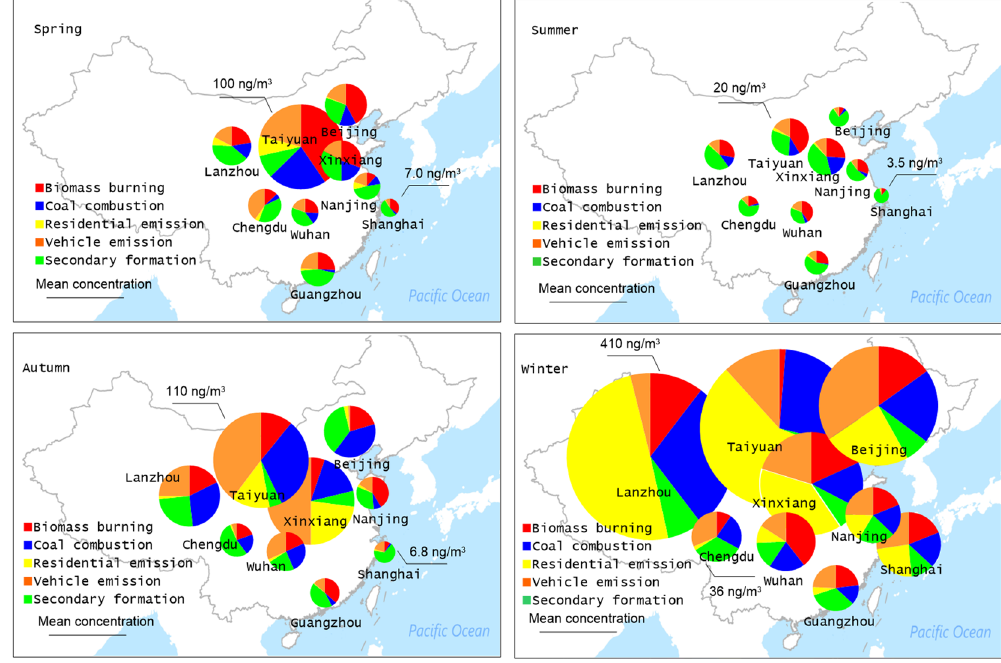
Figure 5. Contributions of the five sources to the total PAHs in PM2.5 at 9 urban cities over four seasons. (the background map was made using surfer 8.0 by one